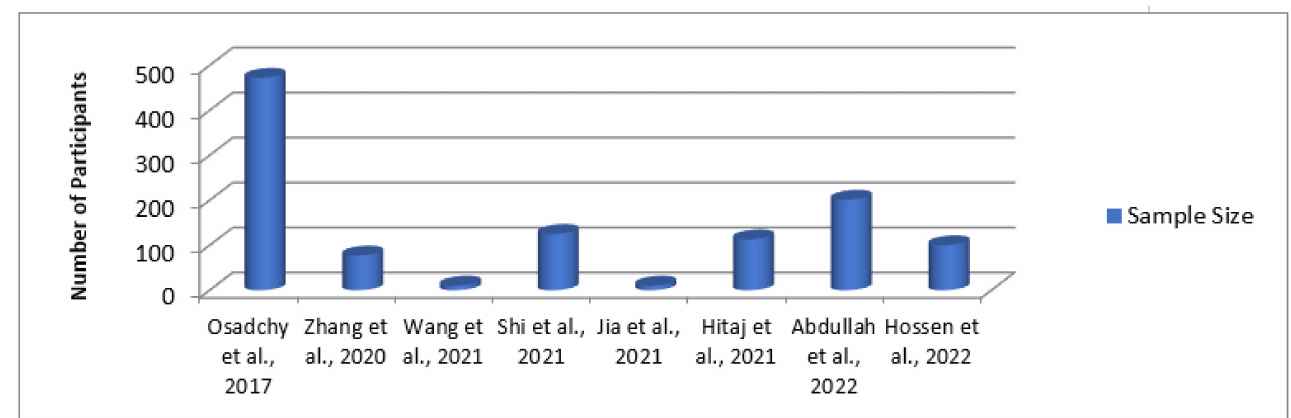
Figure 3. The sample size used in each study to date: